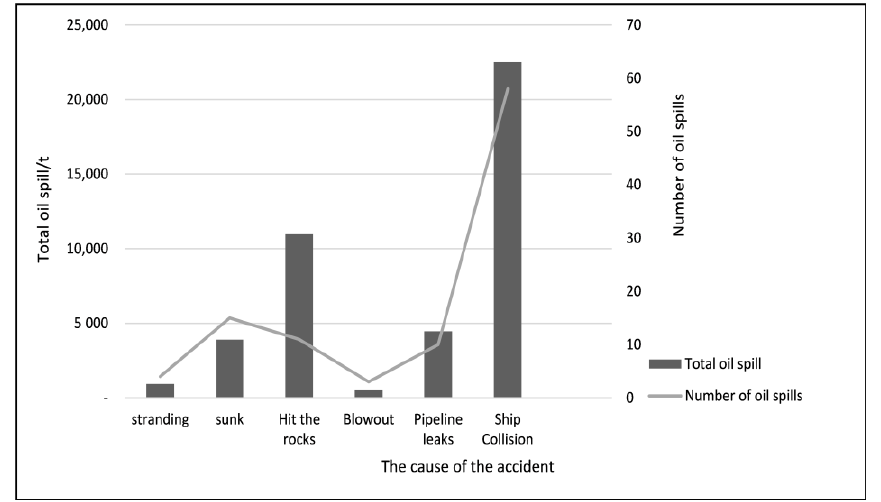
Figure 1. Causes of marine oil spill accidents of 50 tons and above in China, 1974-2018 statistics.